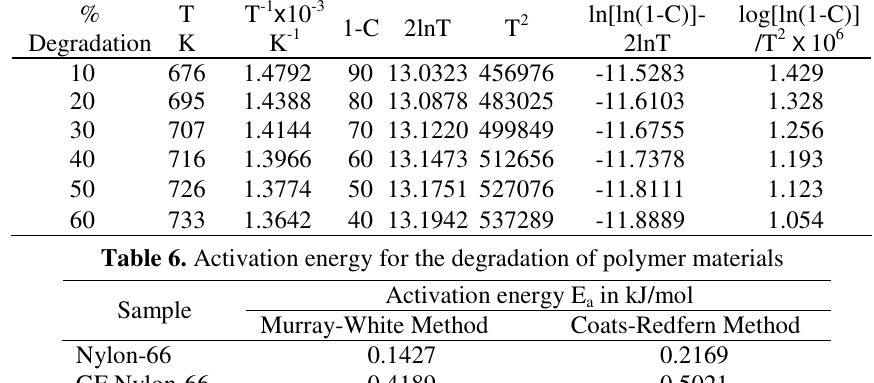
Table 5. Calculation of activation energy for the degradation of 30% GF nylon-66